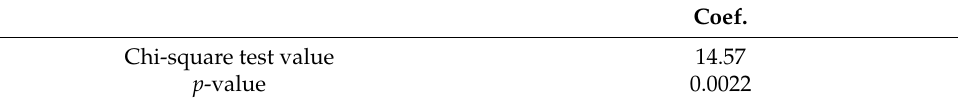
Table A3. Hausman (1978) specification